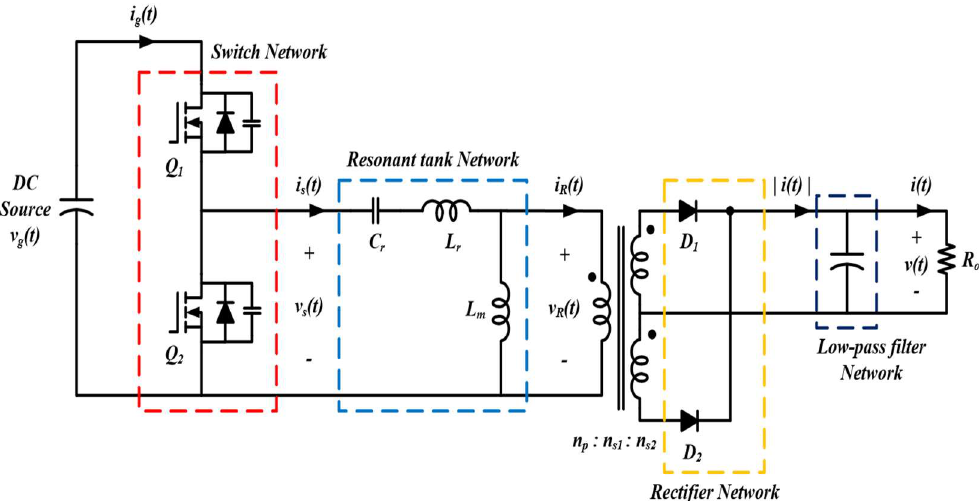
Figure 2. Half-bridge Converter Topology for BRPVS.